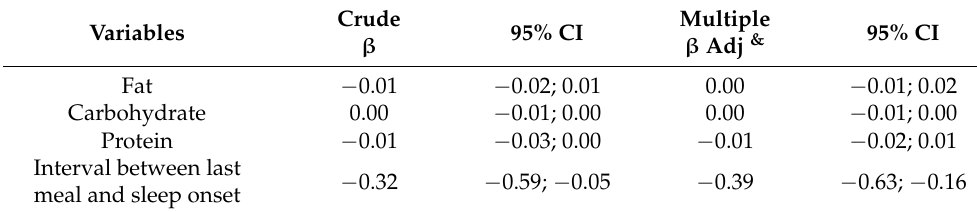
Table 1. Sleep duration after night shift (diurnal sleep) ( n = 28).